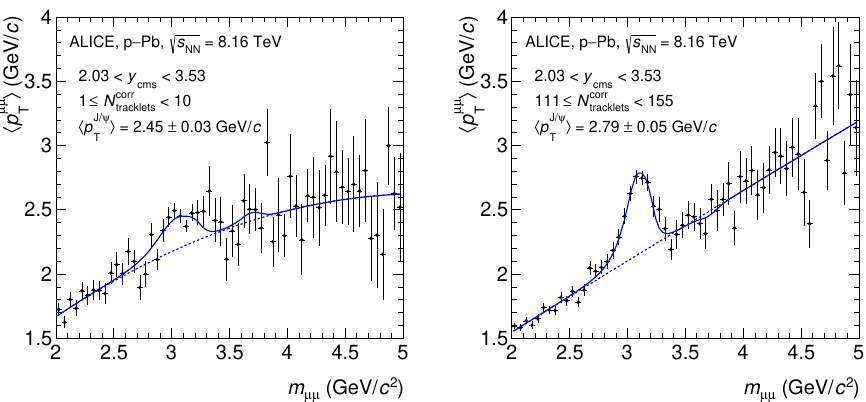
Figure 2 . Average transverse momentum of opposite-sign muon pairs for selected multiplicity intervals, corrected for the J = acceptance and e(cid:14)ciency. The distributions are shown together with a typical (cid:12)t function (solid line, see text for